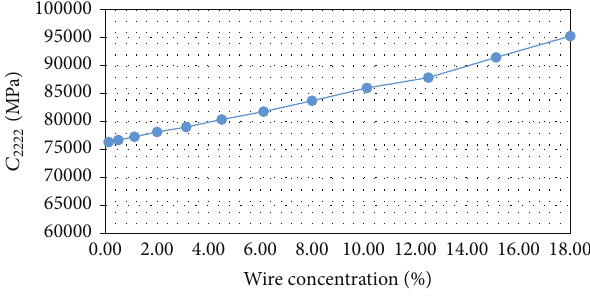
Figure 2: Dependence of coefficient versus concentration of reinforcing wires.